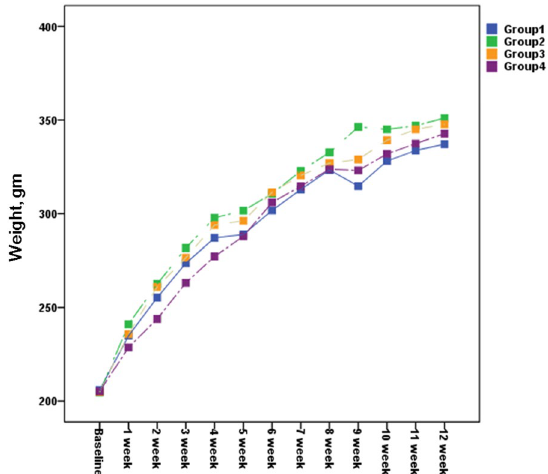
Figure 1. Body weight of the rats following the SiNP applications. There was no statistically significant difference in the body weights of the different groups (Group 1, control; Group 2, oral intake, 100 mg/kg; Group 3, oral intake, 1000 mg/kg; Group 4, topical application, 10 mg/ml) over the 12-week period.